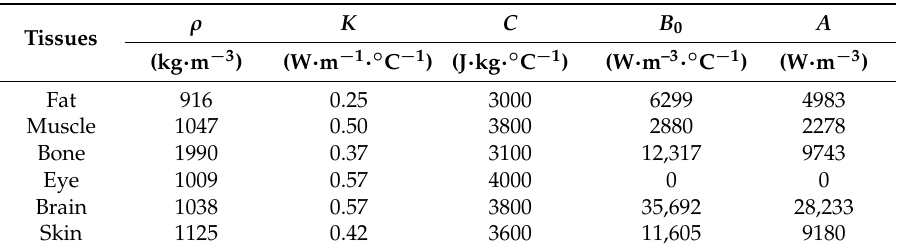
Table 2. Thermal properties of the rat